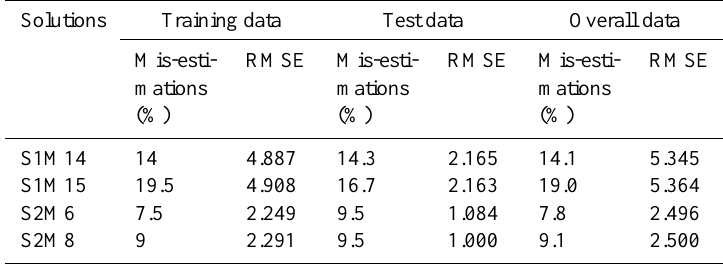
Table 4. Performance of the best two solutions in each series.